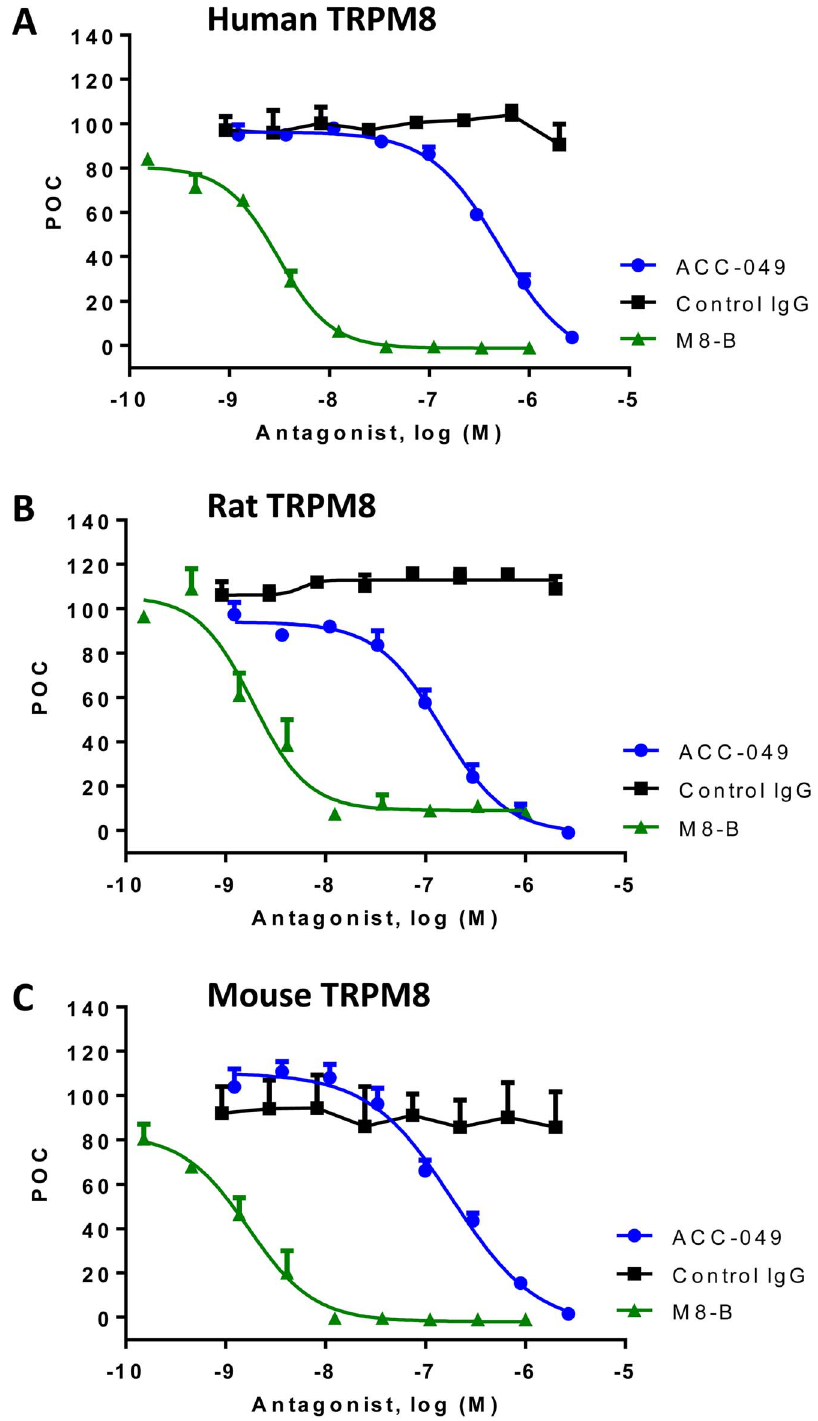
Figure 3. Cold activation of TRPM8. Concentration dependent antagonism of cold activation (10 u C) of the human (A), rat (B), or mouse (C) TRPM8 channels by ACC-049, control IgG and M8-B measured by 45 calcium uptake. Note the right shifted concentration response of ACC-049 on human TRPM8 (A) compared to rat (B) or mouse (C) TRPM8, while the small molecule antagonist positive control M8-B exhibited comparable responses on TRPM8 channels of all species tested (A–C). Values are means of triplicate measures in a single experiment and expressed as percent of control (POC). Cold induced 45 Ca 2 + uptake was considered as 100 percent and wells with M8-B at 1 m M plus 45 Ca 2 + were set as zero percent.